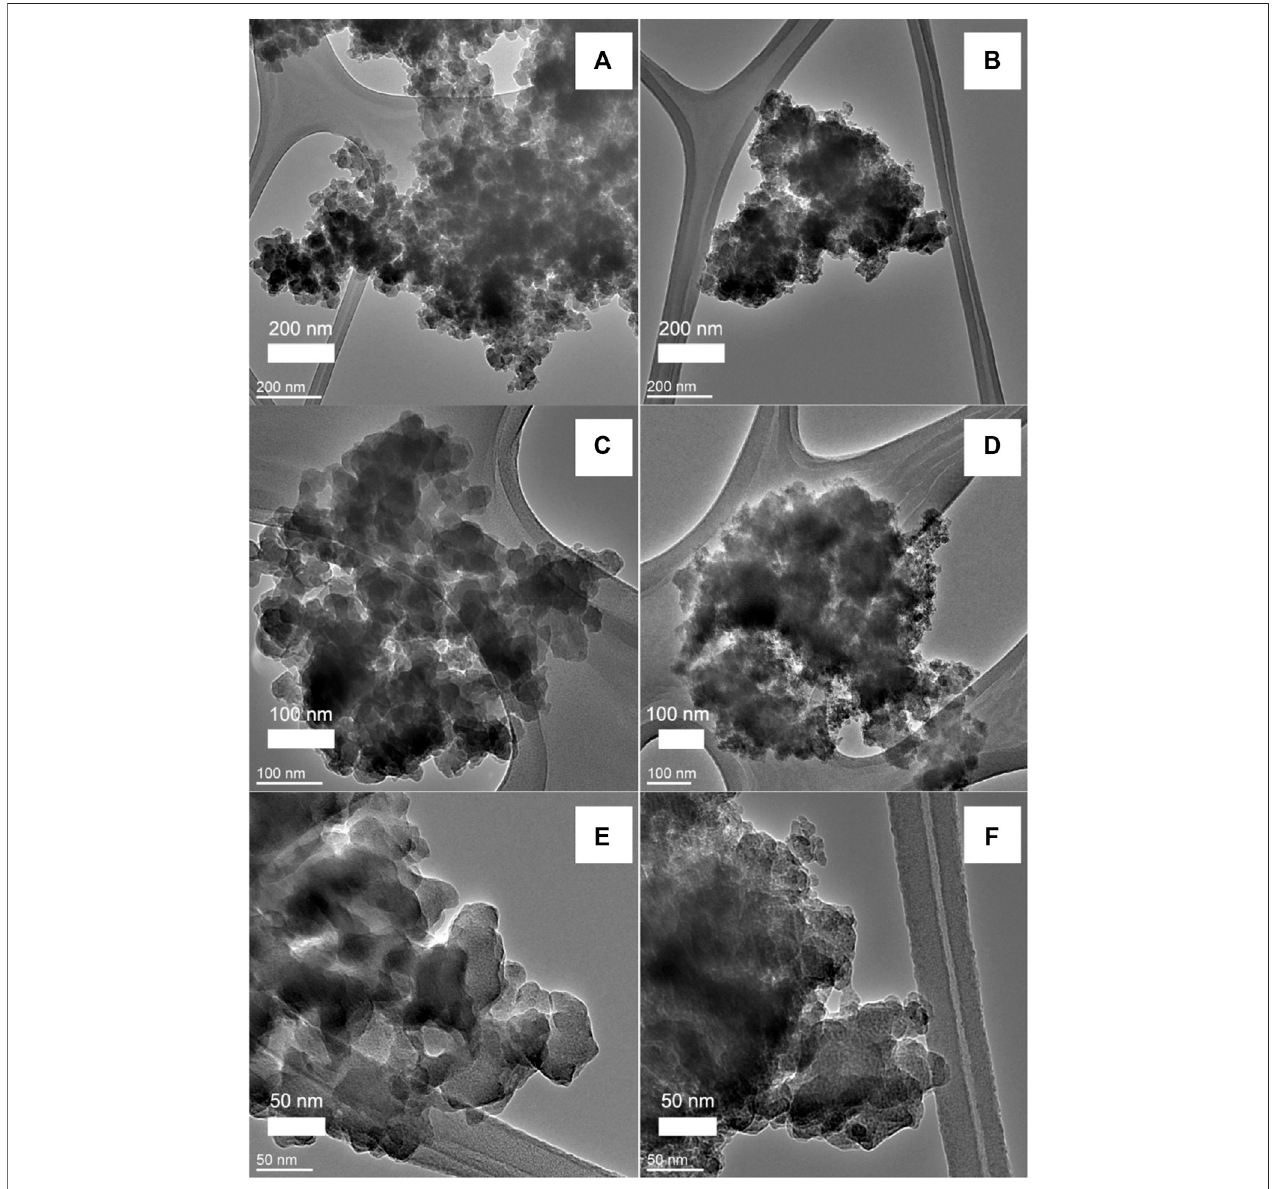
FIGURE 6 | TEM images of freeze-dried samples DGP-W (A, C, E) and DGP-A (B, D, F) with increasing magni fi cation from top to bottom.